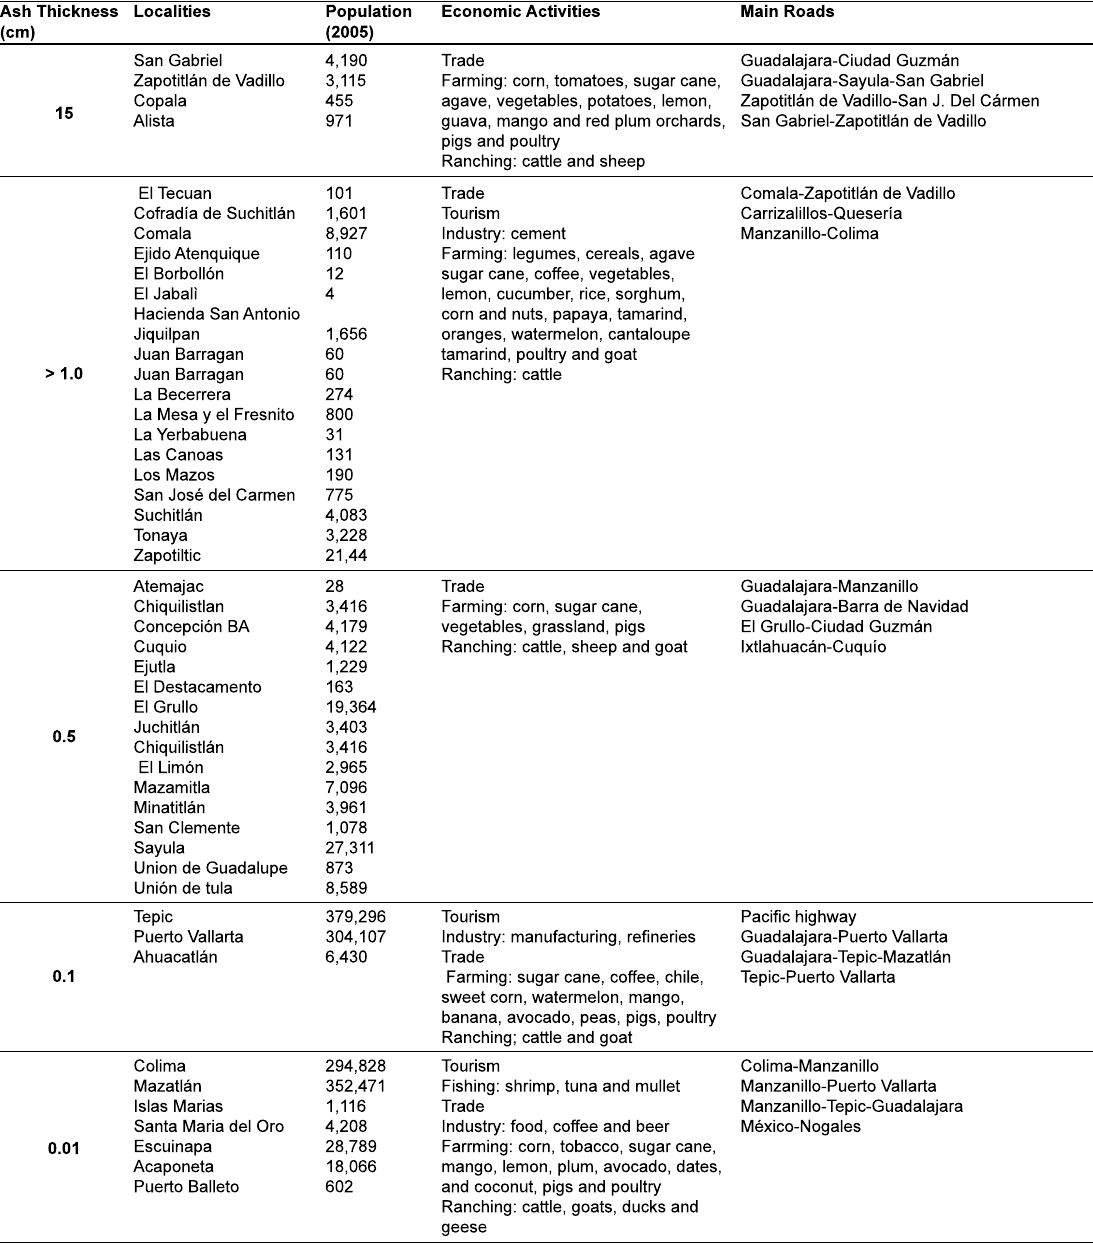
! Table 9. Scenario 5. Localities, populations, main economic activities and roads which would be affected by different ash-fall levels during an eruption occurring from June to